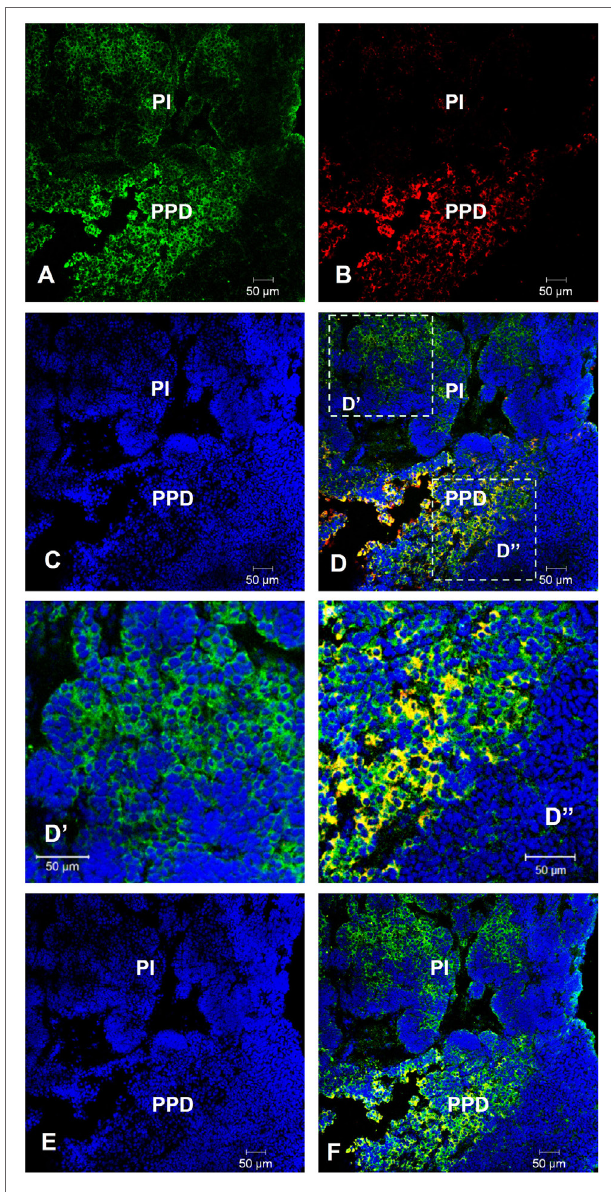
FigUre 4 | Co-localization of lepR and Lh in non-transgenic common carp pituitary. In situ hybridization of lepR (green) and immunofluorescence of Lh (red) in 8-month-old female (a–D,D ′ ,D ″ ) and male (e,F) common carp pituitary. Yellow-orange color indicates colocalization. PI, pars intermedia; PPD, proximal pars distalis. Scale bar, 50 µm.